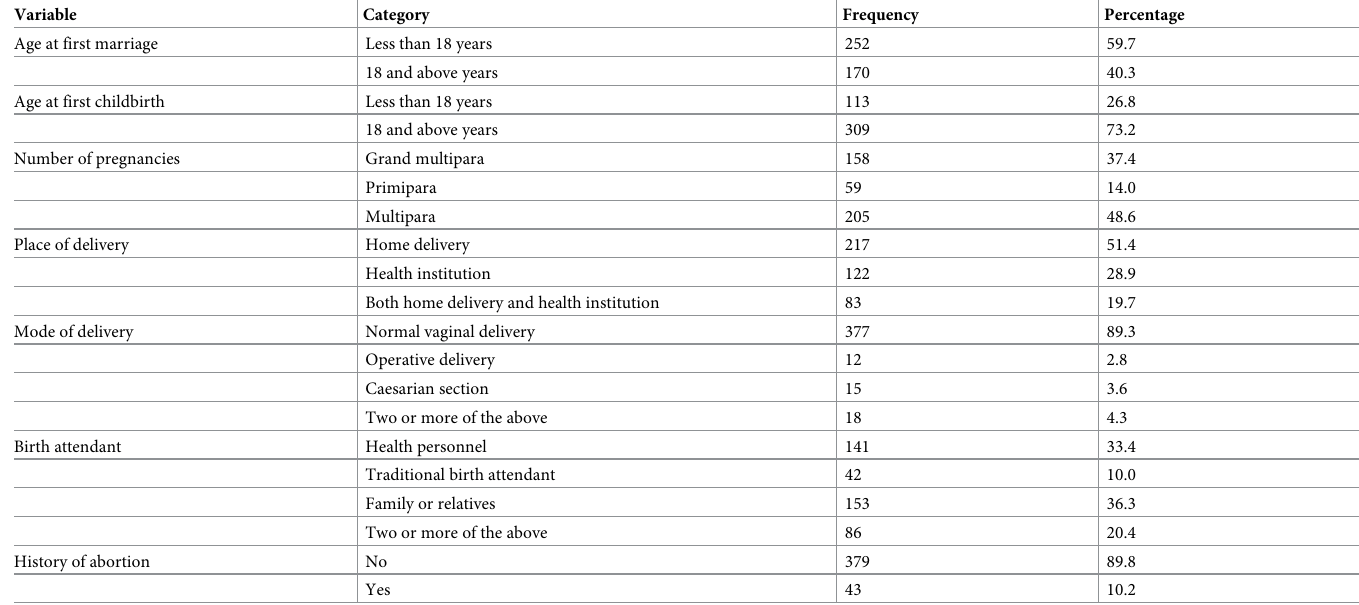
Table 3. Obstetric and gynecological characteristics of study participants in Loma Woreda, Dawuro Zone, Ethiopia 2020 (n =